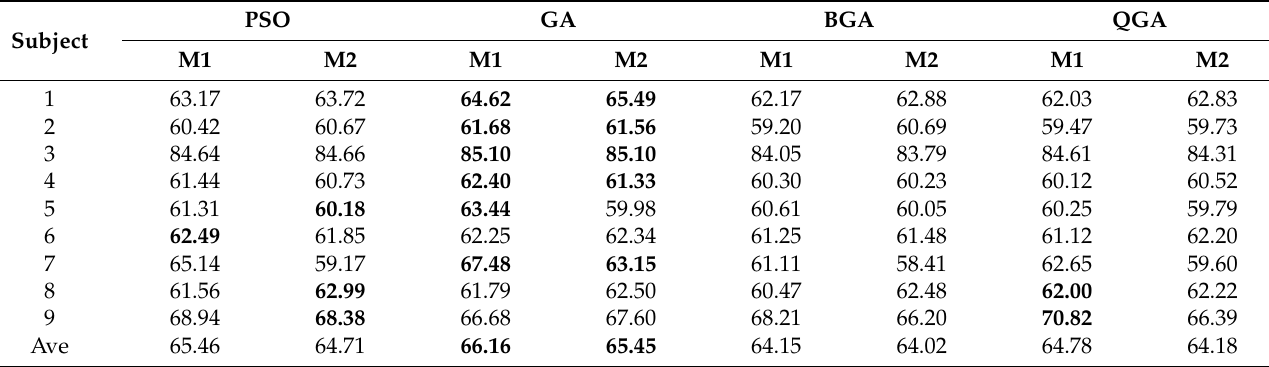
Table 13. The results of algorithms with four methods (TD, FD, wavelet, and autoregression) on two channels (C3 = 8 and C4 = 12) with FB 2 & 5 (25).